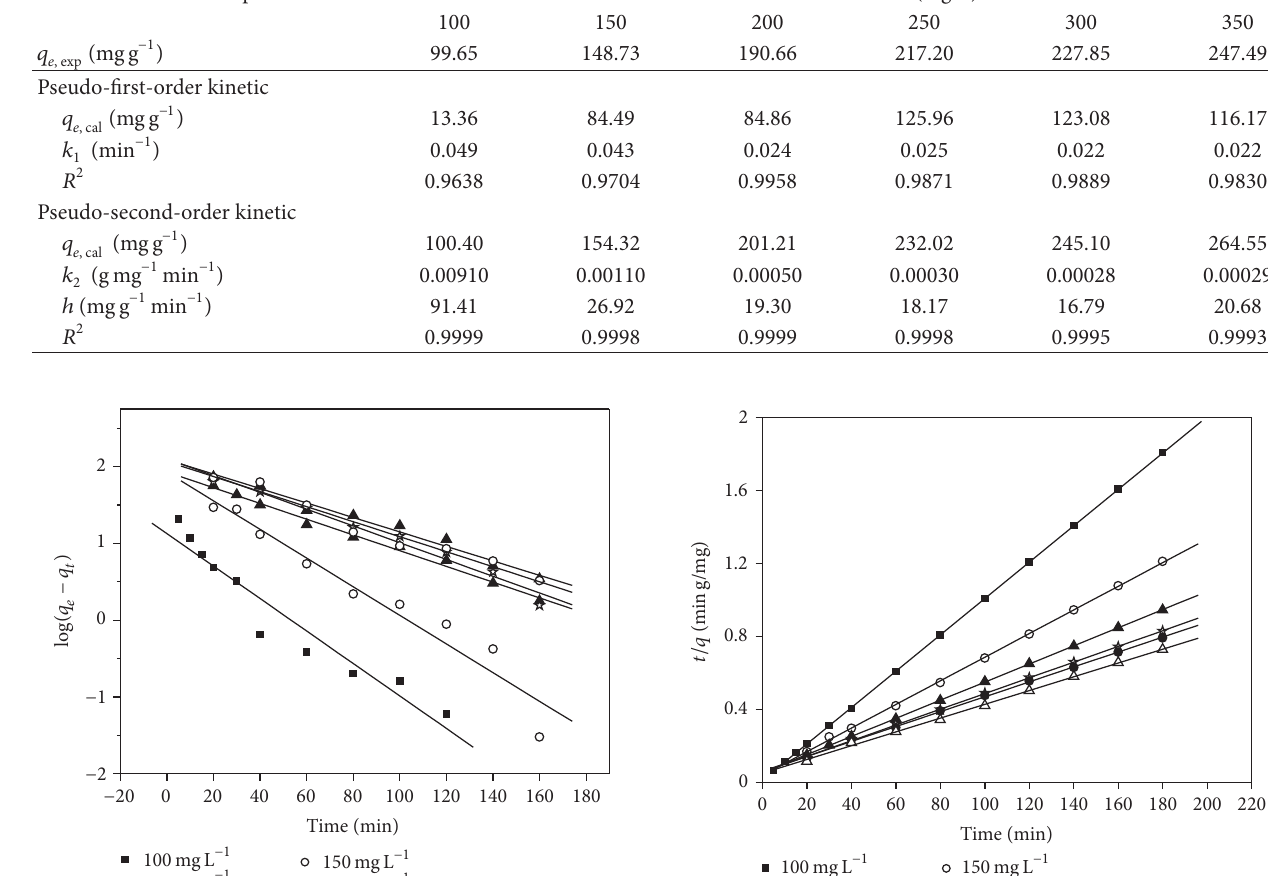
T 3: Pseudo-�rst-order and pseudo-second-order models for the adsorption on activated carbon prepared from pea shell. Kinetic models and its parameters